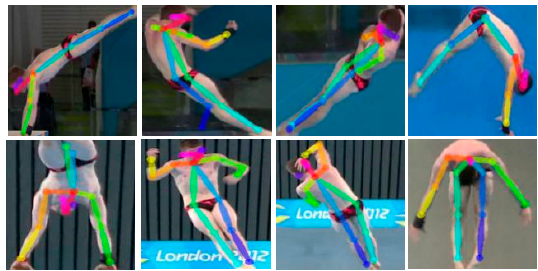
Figure 5. Joint trajectories of two different views for the same person performing diving. (The first row shows results on the side view and the second row presents results on the front view.).